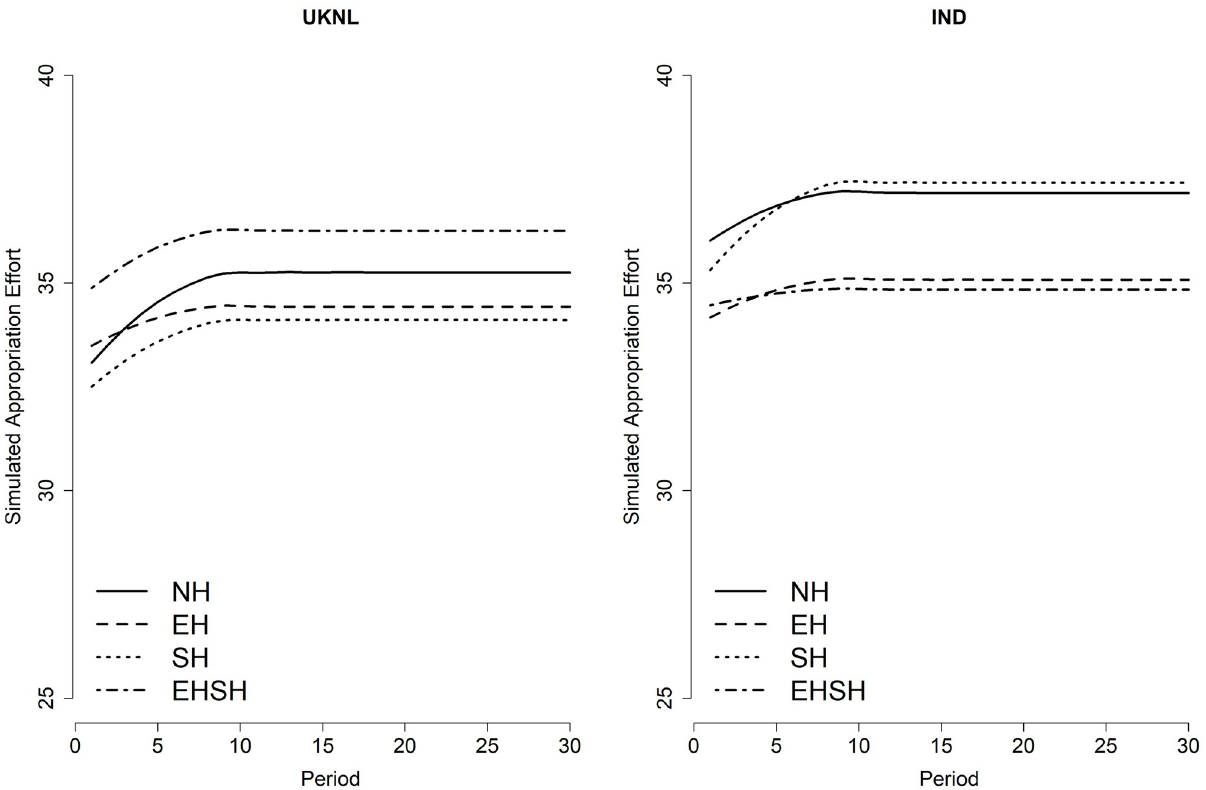
Fig 13. Smoothed simulated average appropriation effort per treatment per